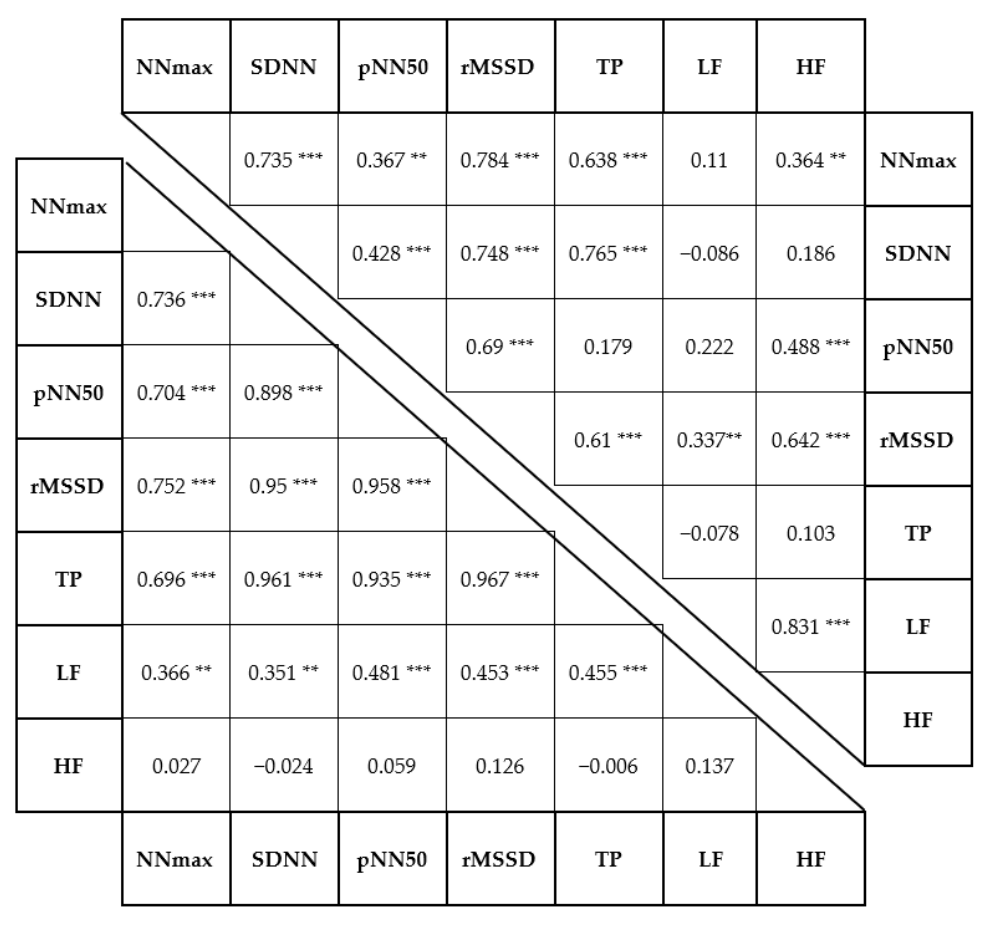
Table 3. Correlations between the delta values of the HRV indicies. The results of the physical stress test can be seen in the upper right part of the table, whereas the buttom left part contents the results of the psychological stress protocol. Statistical significance is indicated by stars (** p < 0.01, *** p < 0.001). Abbreviations: see Table